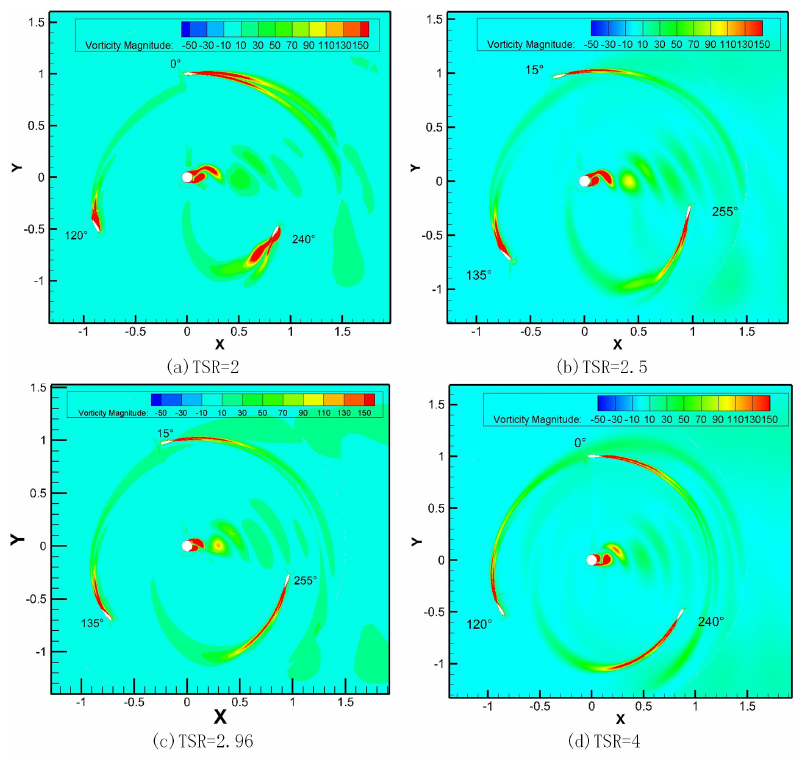
Figure 18. Vorticity diagram of two-dimensional wind generator with different